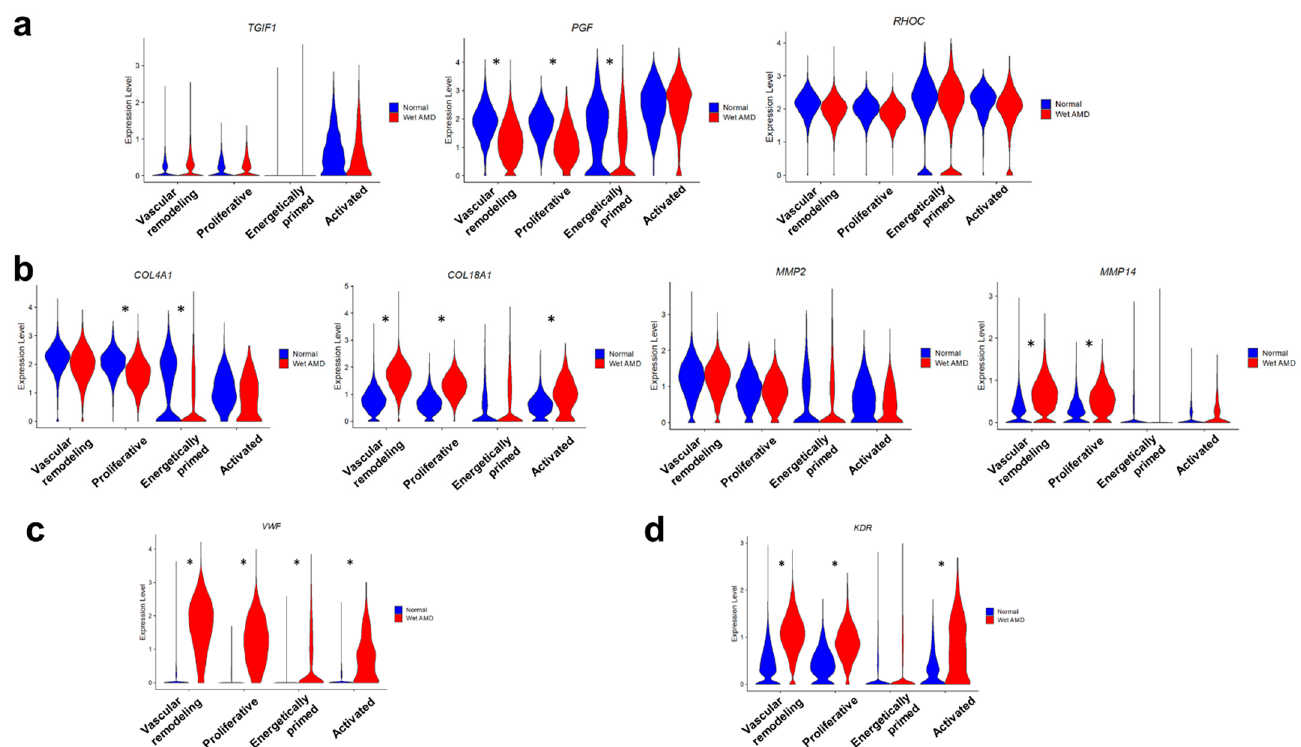
Figure 3. Benchmarking of human sprouting BOECs to in vivo choroidal neovascularization profiles. ( a ) Violin plots showing expressions of curated CNV tip endothelial cell markers based on Rohlenova et al. ( b ) Violin plots showing expressions of collagen genes and matrix metalloproteinases. ( c ) Violin plot showing expression of VWF , an injury marker, in normal and wet AMD sprouting BOECs. ( d ) Violin plot showing expression of KDR , a VEGF receptor, in normal and wet AMD sprouting BOECs. Asterisks mark significant differential expression between wet AMD and normal BOECs within each cluster, as determined using FindMarkers .